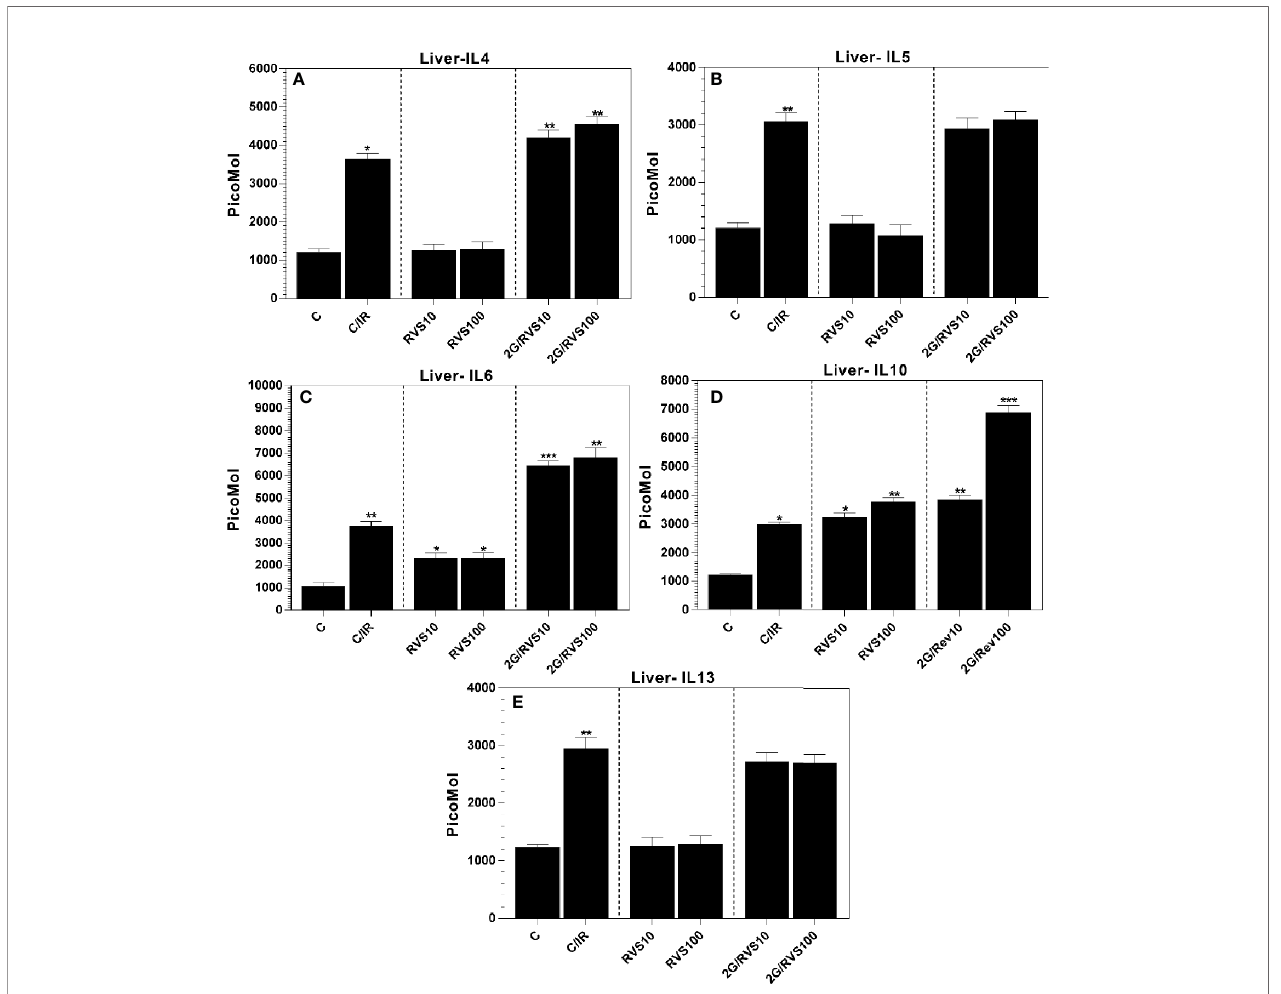
FIGURE 2 | The cytokine pro fi les in Wistar rat liver produced by Th2 cells, which include (A) IL-4, (B) IL-5, (C) IL-6, (D) IL10, and (E) IL-13 in six rat groups. (C, control group; C/IR, irradiated rats, RSV10 and RSV100; irradiated rats with 2 Gy pretreated with resveratrol 10 mg 100 mg/kg body weight, respectively). C/IR are compared to C; RSV10 or RSV100 are compared to C; 2G/RSV10 or 2G/RSV100 are compared to C/IR. *p < 0.05, **p < 0.01, ***p <